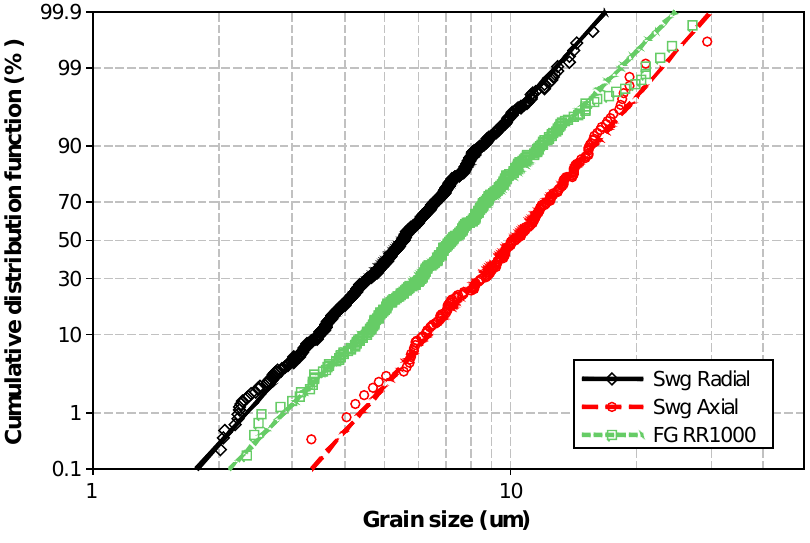
Figure 6. Cumulative distribution plot of Feret diameters, pre and post swaging.